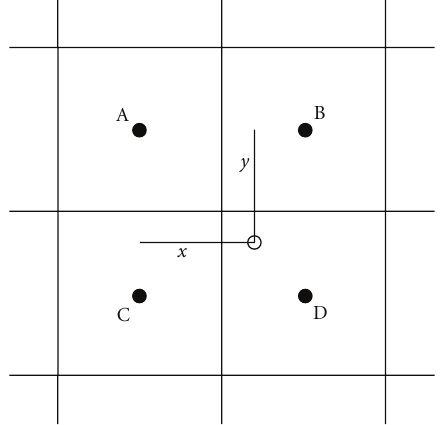
Figure 1: Image sample divided in 4 contextual